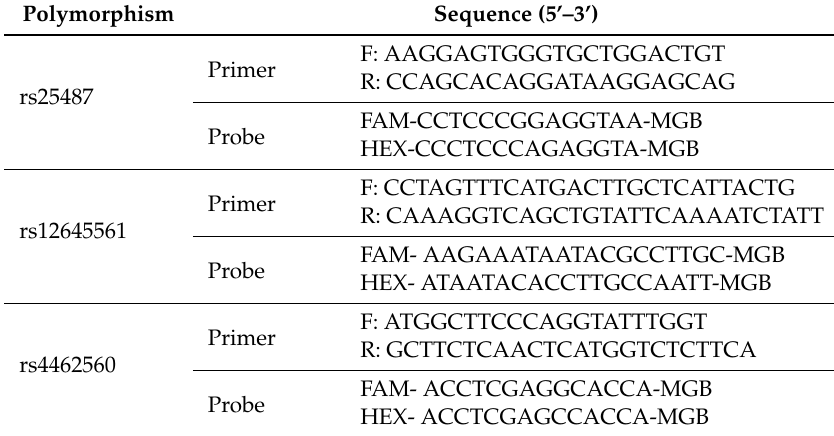
Table A1. Information of primers and probes for TaqMan allelic